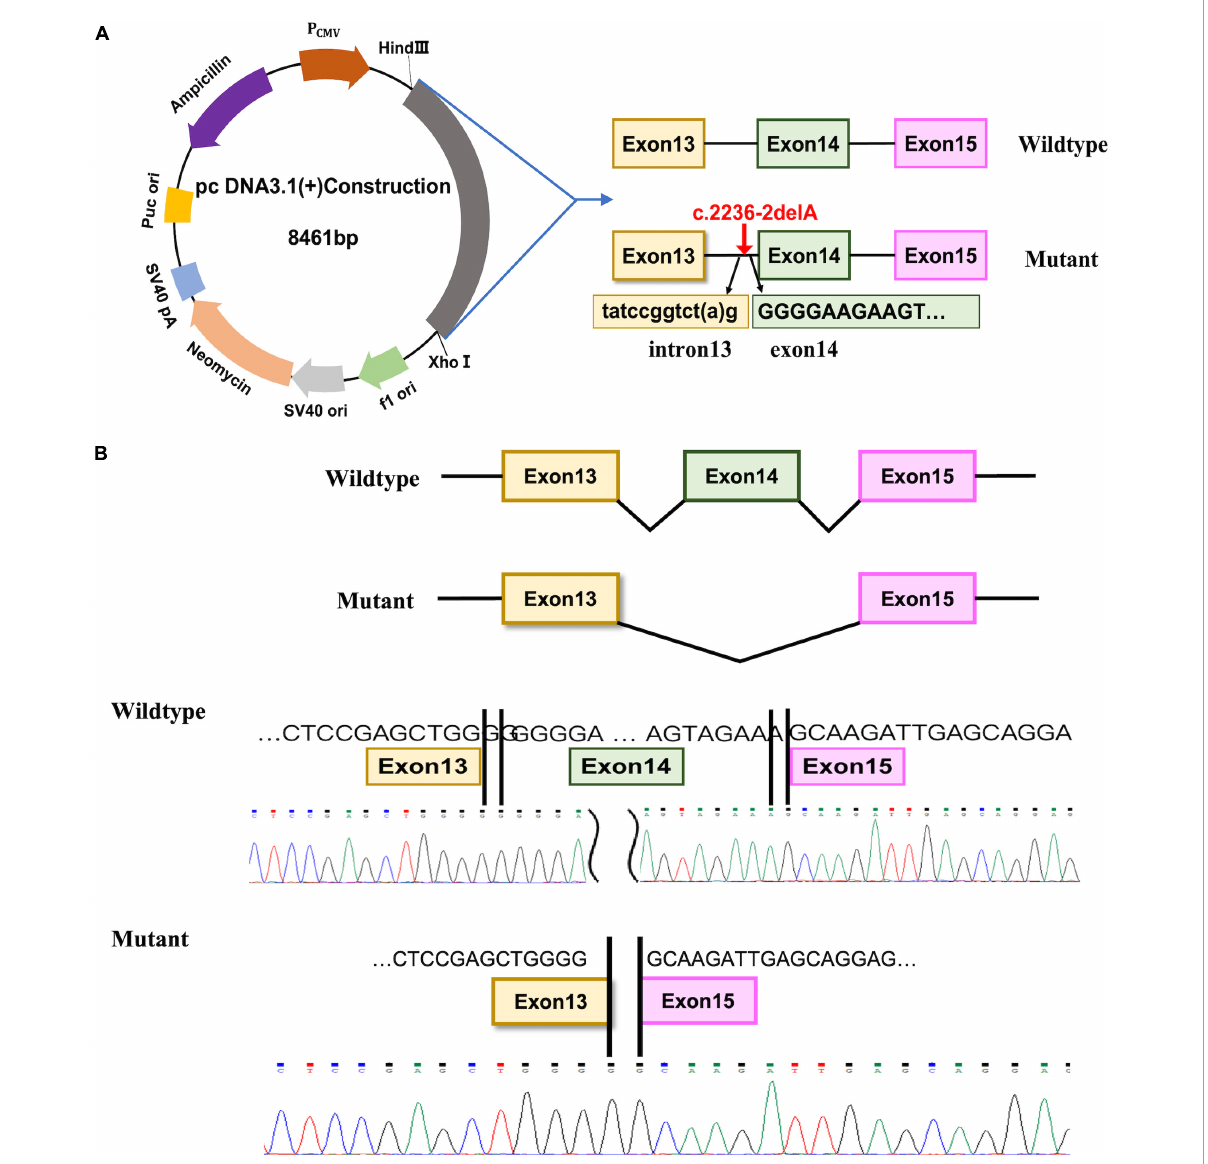
FIGURE3 Minigene assay and Sanger sequencing of spliced transcripts. (A) Diagram of the DNA, the location of c.2236-2delA mutation and the fragment inserted into the pcDNA3.1(+) plasmid. (B) The spliced sequences and Sanger sequencing chromatogram of the transcripts from the wide-type and the mutated